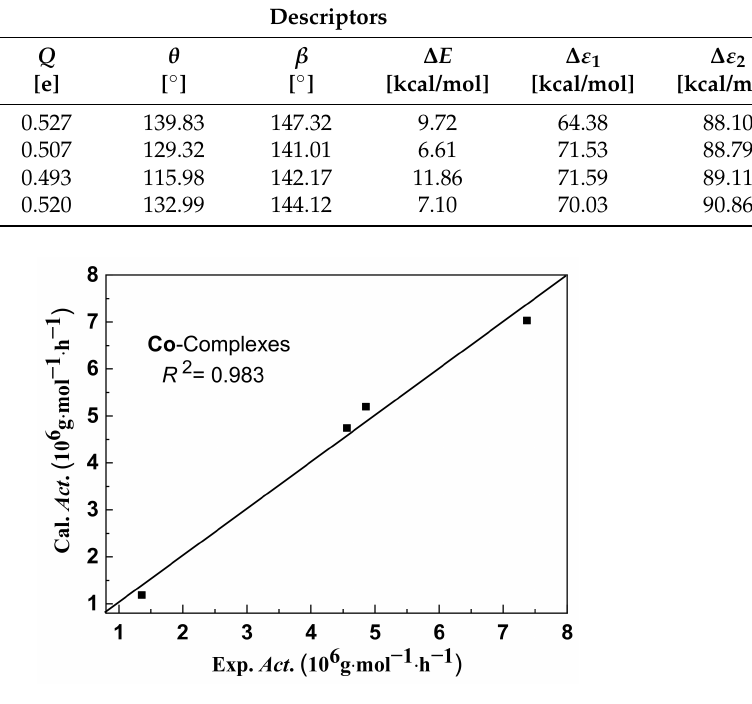
Figure 13. Comparisons between calculated and experimental activities of Co complexes by the descriptors of open cone angle ( θ ) and effective net charge ( Q eff